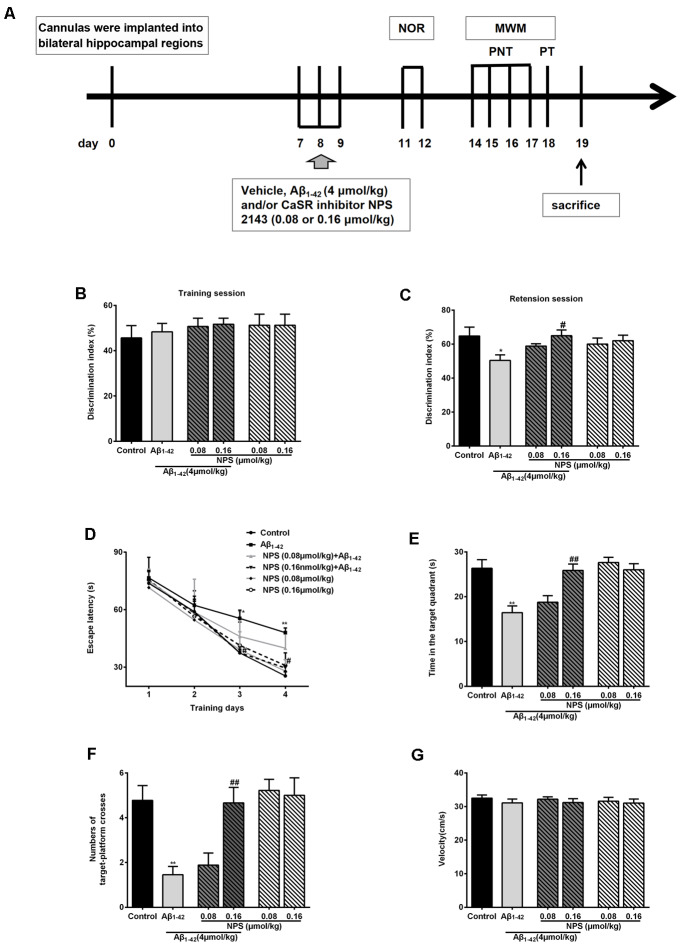
Protective function of inhibiting CaSR on oligomeric Aβ1–42-induced recognitive and spatial learning deficits. (A) Experimental schedule of behavioral tests. Cannulas were implanted into bilateral hippocampal regions. Vehicle, Aβ1–42 (4 μmol/kg) and/or CaSR inhibitor NPS 2143 (0.08 or 0.16 μmol/kg body weight per day) were microinjected for 3 days from day 7 to 9. From day 11 to day 12, the novel object recognition (NOR) tests were performed. Morris water maze (MWM) tests were conducted from day 14 to 18 day. Place navigation tests (PNT) of the MWM were conducted four times a day for four consecutive days, followed by a probe trial test (PT) 24 h after the last PNT. The mice were sacrificed after behavioral experiments. (B) Discrimination indexes displayed no significant difference among these groups in the training session. (C) Quantitative comparison of the discrimination indexes in the retention session, n = 8 animals for each group. (D) The escape latency of the control, the oligomeric Aβ1–42-treated group (4 μmol/kg), and/or the NPS 2143-treated group (0.08 or 0.16 μmol/kg) during the four training days. (E) Quantitative comparison of the time in the target quadrant of the six groups. (F) Quantitative comparison of the number of target platform crosses of the six groups. (G) Swimming speed of the six groups did not show significant different. *P < 0.05 vs. control group, **P < 0.01 vs. control group, #P < 0.05 vs. Aβ1–42 oligomer-treated group, ##P < 0.01 vs. Aβ1–42 oligomer-treated group. Values represent mean ± SEM, n = 8 animals for each group.